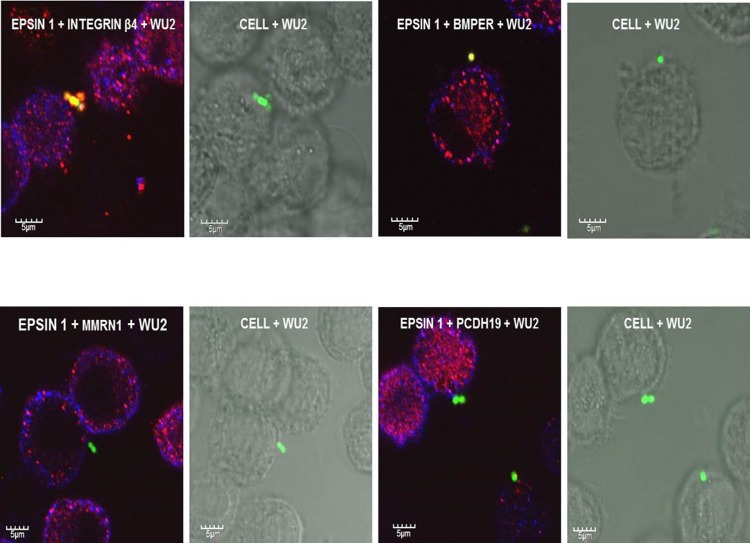
Immunostaining of S. pneumoniae adhesion to A549 cells.CFDA-stained S. pneumoniae strain WU2 cells were incubated with A549 cells for 1 h. Excess bacteria were removed, and the culture was fixed with 4% para-formaldehyde, stained, and viewed with a FluoView FV1000 confocal system (Olympus, Japan). The following stains were used: A) mouse anti-Eps 1 antiserum and rabbit anti-integrin β4 antiserum; C) mouse anti-epsin 1 antiserum and rabbit anti-BMPER antiserum; E) mouse anti-Eps 1 antiserum and rabbit anti-MMRN1 antiserum; and G) mouse anti-Eps 1 antiserum and anti-PCDH19 antiserum. The same cells viewed by Nomarsky microscopy overlaid with the CFDA-stained bacteria are shown, respectively, in B), D), F) and H). Secondary antibodies used were Alexa Fluor 405-conjugated AffiniPure Goat Anti-Mouse IgG (H+L) antiserum and Alexa Fluor 594-conjugated AffiniPure Goat Anti-Rabbit IgG (H+L (antiserum, in accordance with the primary antiserum used.